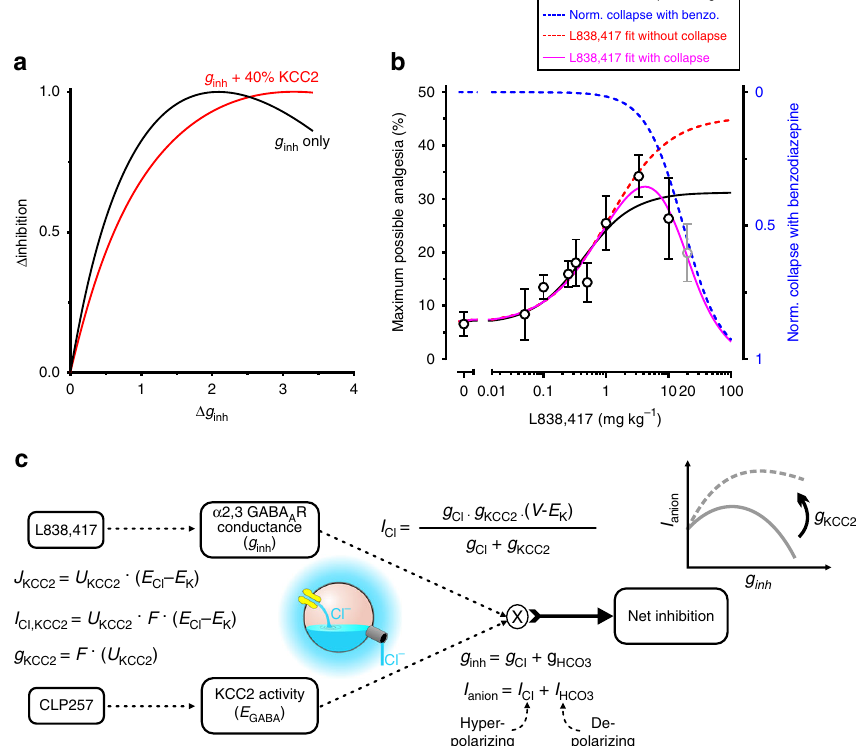
Fig. 8 Dual advantage of enhancing KCC2: L838,417 potency and ef fi cacy improvement. a Computer simulations predicting a collapse in anionic current when inhibitory conductance ( g inh ) is increased beyond an optimal value (black curve, see methods). When an increase of 40% in the strength of Cl − extrusion through KCC2 was simulated, the collapse in anionic current for large inhibitory conductance was prevented (red curve as in Fig. 4e). b Experimental MPA (maximum possible analgesia) with L838,417 (black empty dots) was fi tted with a Hill equation (black curve) where the last data point was ignored (which correspond to a decline in analgesia). To better describe the collapse in inhibition occurring at high L838,417 doses, two independent processes were combined to generate the fi nal fi tting function. The fi tting function (purple curve, Eq. 4) that takes into account the collapse consists of the product of a normal dose-response curve (Eq. 2) without collapse (dashed red curve with amplitude set to the value obtained in Fig. 6g) and an inverse normalized dose-response curve representing the collapse (dashed blue curve). Combining the two independent processes in a single fi tting function (purple curve) yielded a better global fi t of the experimental MPA with L838,417 than a simple Hill fi t (black curve). c A schematic representation of how CLP257 and L838,417 synergistically act on net inhibition. L838,417 increases anionic conductance while CLP257 favors Cl − extrusion via KCC2. This, in turns interacts to determine the value of Cl − reversal potential as well as the net anionic current which promotes analgesia 155 . F is the Faraday constant, J denotes a fl ux and U is a proportionality constant capturing the strength of KCC2 activity (see Methods). Source data is available as a Source Data fi